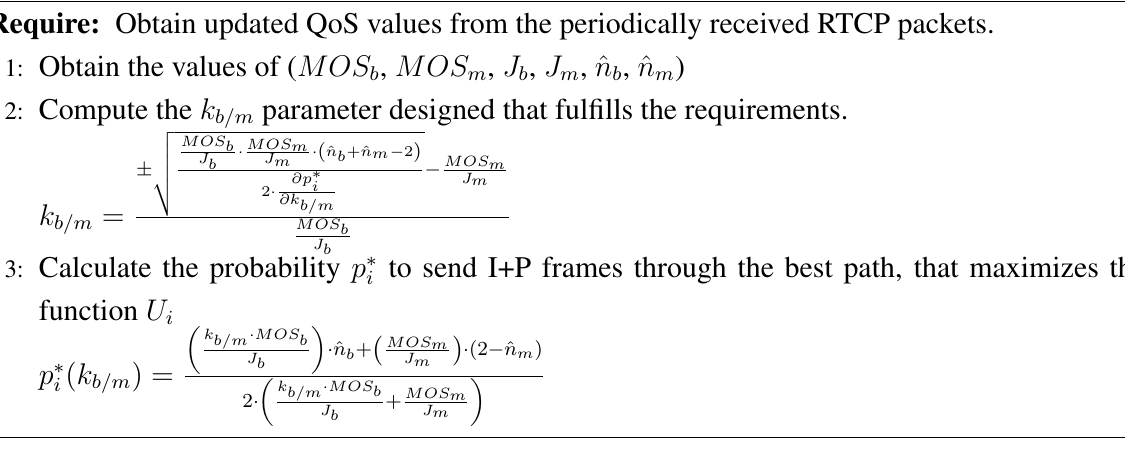
Algorithm 1 Calculation of p ∗ , the best response probability for player i that maximizes his/her utility i function U i